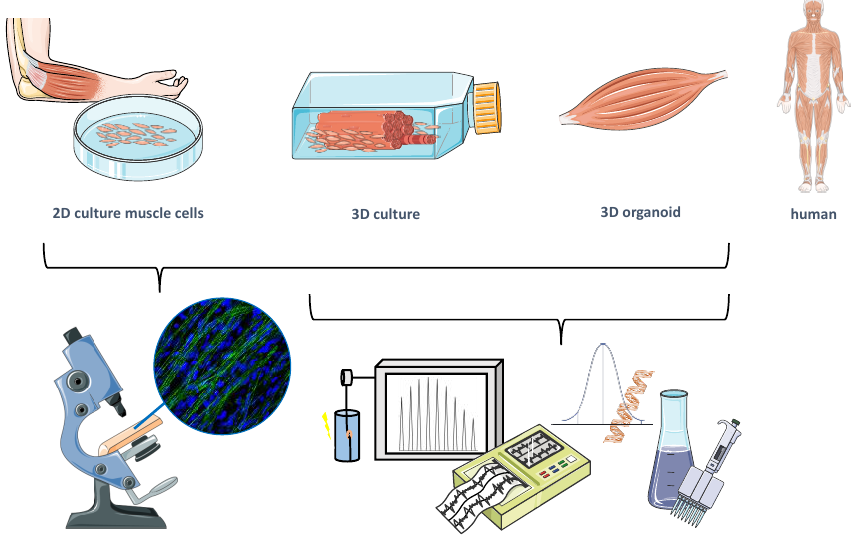
Figure 1. Evolution of cellular tools.